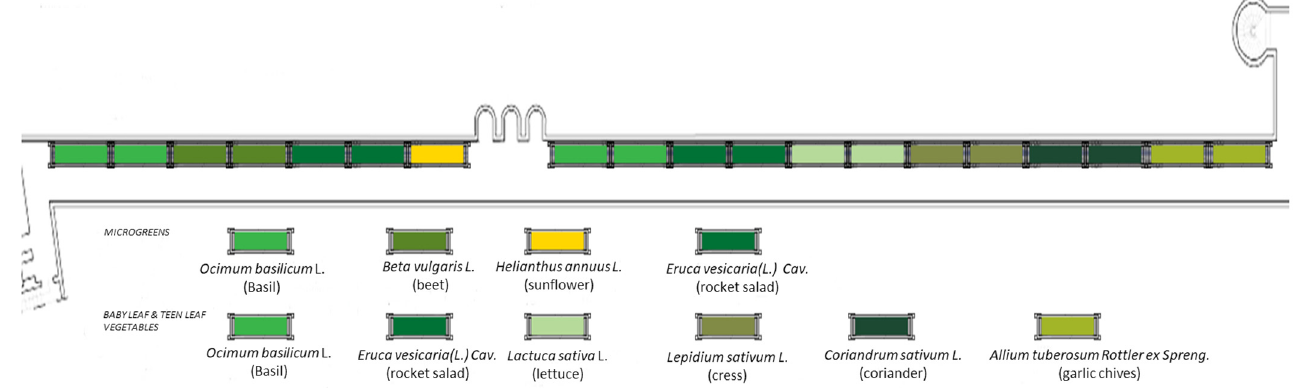
Figure 10. Outline of the cultivation by type of vegetables. Elaboration by A. Pilo.